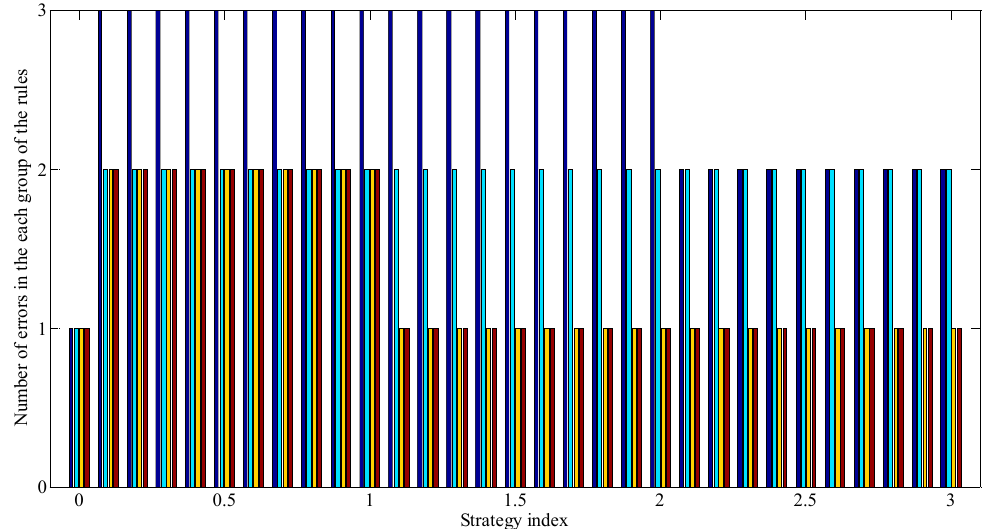
Figure 7. Dependence of the number of classification errors in the final GDRC on the assessment strategy.